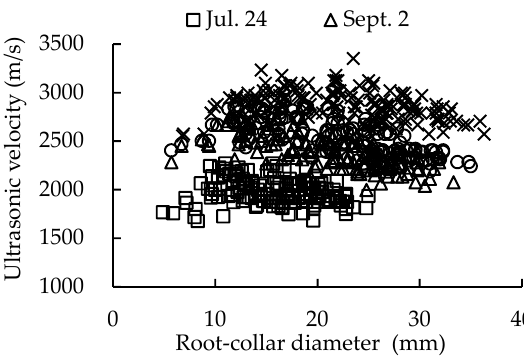
Figure 9. Relationship between the ultrasonic velocity and root-collar diameter of seedlings.